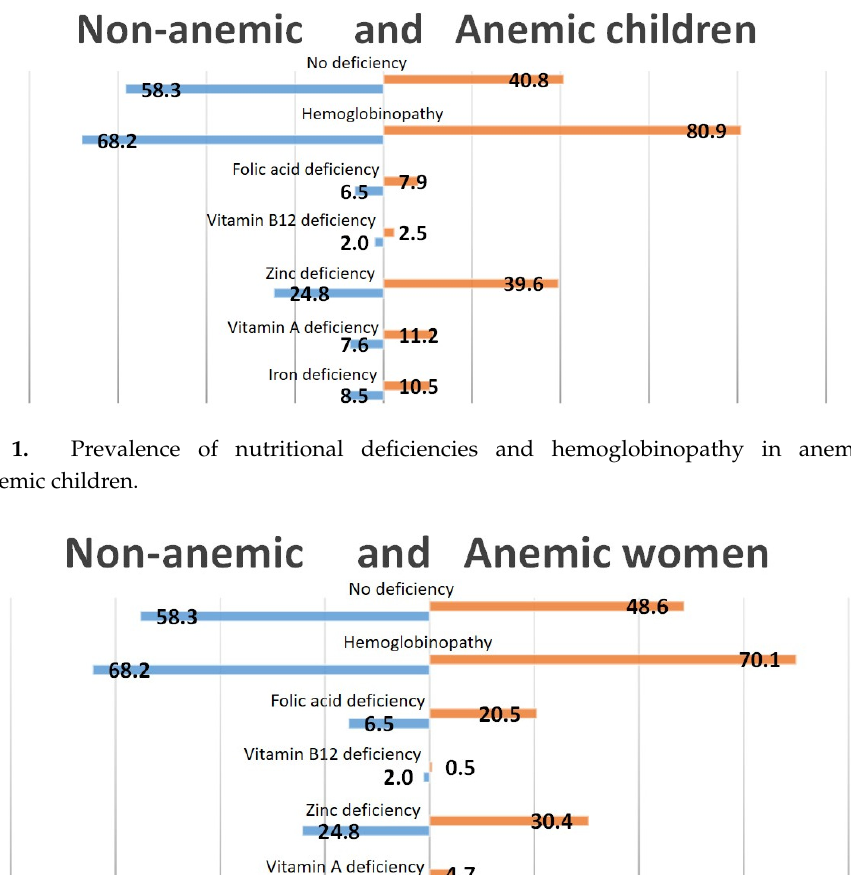
Figure 2. Prevalence of nutritional deficiencies and hemoglobinopathy in anemic and non ‐ anemic